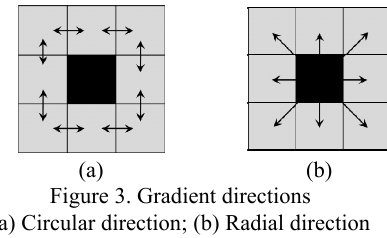
Figure 3. Gradient directions (a) Circular direction; (b) Radial direction